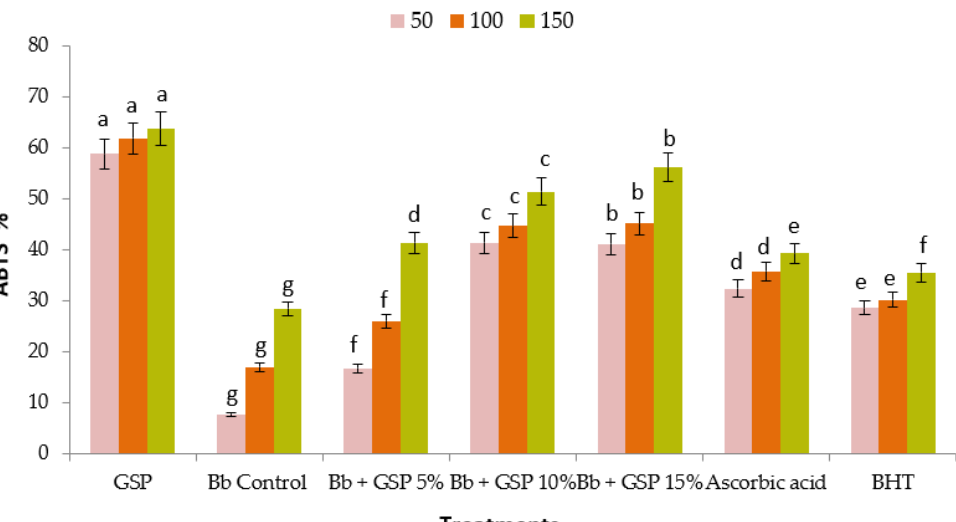
Figure 5. Antioxidants capacity % of balady bread (Bb) supplemented with different ratios of grape seed powder (GSP) extracts at different concentrations ( μ g/mL) against ABTS. Each value is a mean ( ± SD) of three replicates. The different letters on the same bar show a significant difference according to Duncan’s test at p ≤ 0.05.